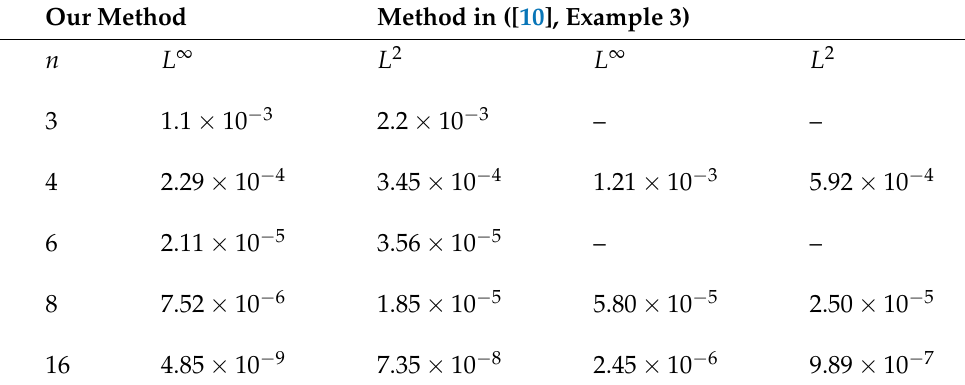
Table 6. Approximate results of Example 3 at various values of n